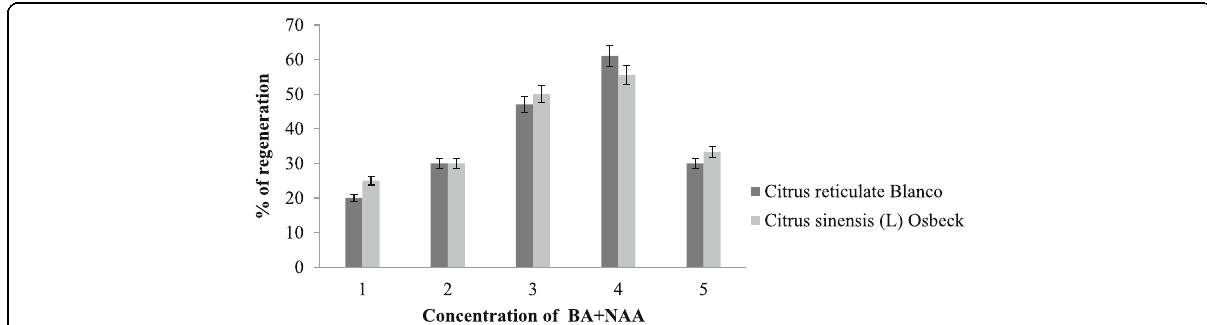
Fig. 6 Effect of BA and NAA at different concentrations on regeneration of transformed calli Here, 1 = 2.0 BA + 1.0 NAA; 2 = 2.5 BA + 1.0 NAA; 3 = 3.0 BA + 1.5 NAA; 4 = 3.0 BA + 2.0 NAA; 5 = 3.5 BA + 2.5 NAA